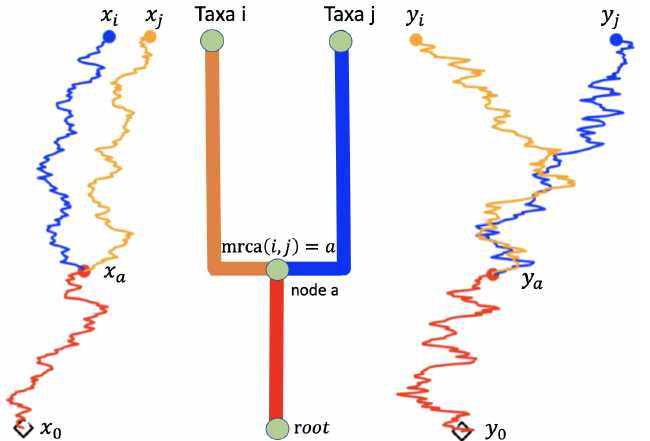
Figure 4. Trait evolution along a phylogenetic fork tree of two species i and j . The two species i and j diverged at time t = t a and evolved independently to their respective tips. The two unknown ancestral values at the root are denoted as x 0 and y 0 , respectively. Two traits X , Y for the i th species ( x ) and the j th species ( x ) are observed at the tips. The two unknown ancestral states at time i , y i j , y j t = t a for trait X and trait Y are denoted as x a and y a , respectively. The dynamics of trait evolution for species along the tree vary with time, which may allow for a correlated relationship to exist between the species